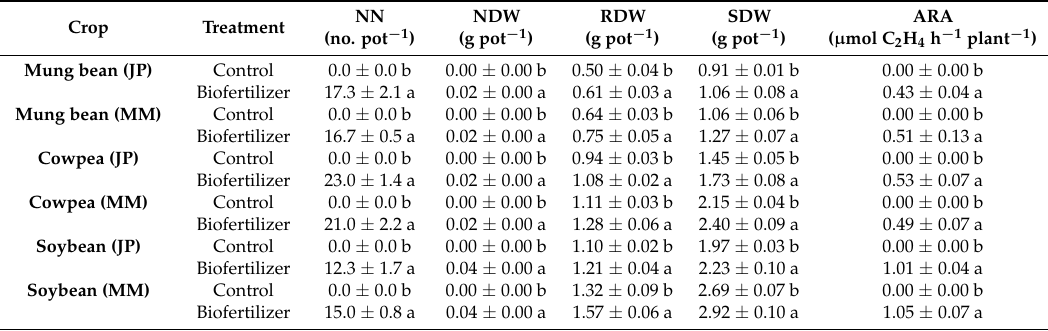
Table 2. Effects of biofertilizer on NN, NDW, RDW, SDW, and ARA of mung beans, cowpeas and soybeans at 30 DAS.